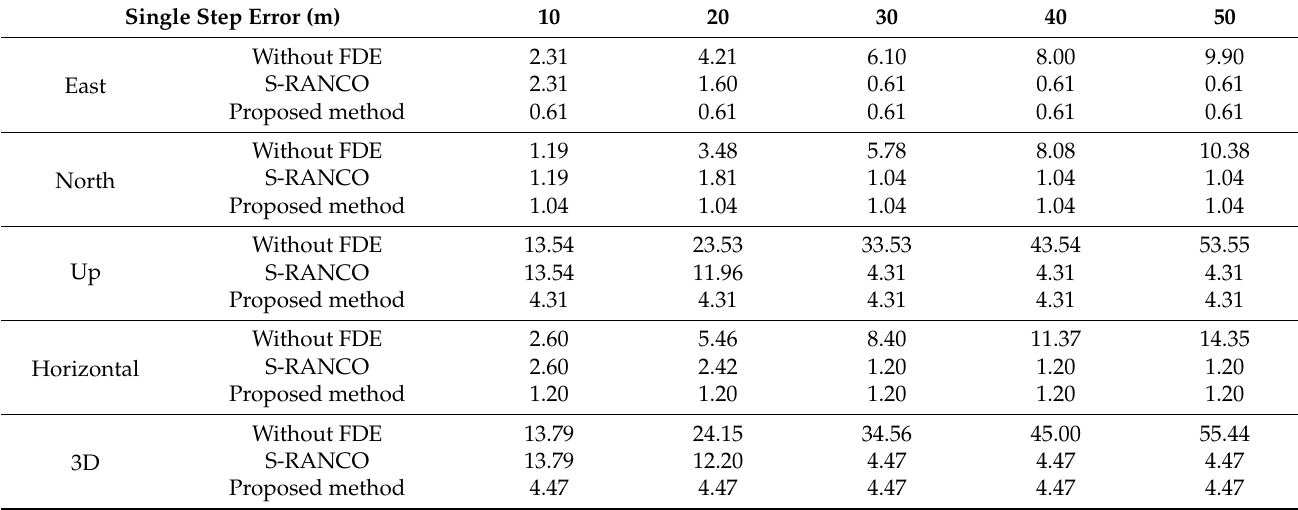
Table 8. The RMSE (m) of positioning results for Scenario 1.